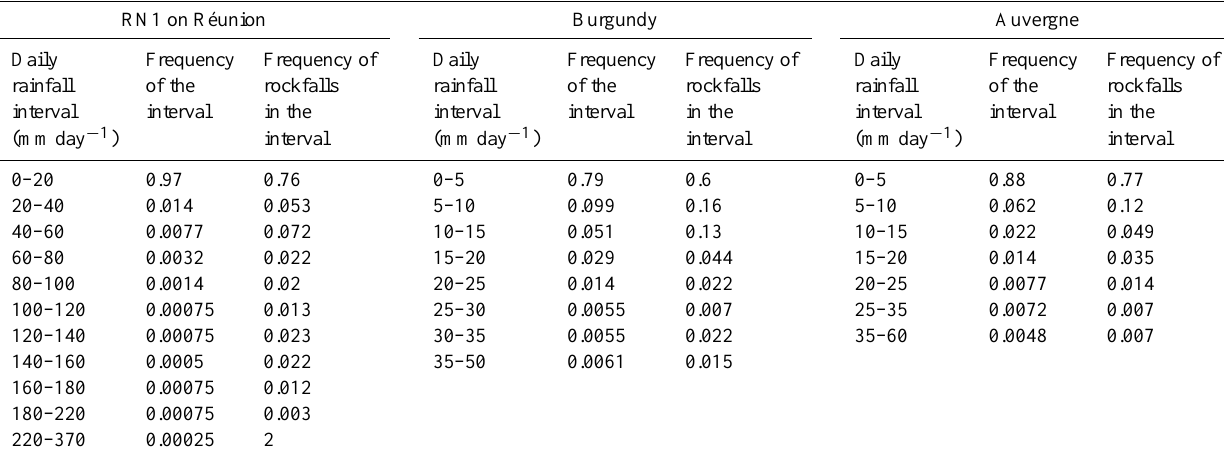
Table 2. Number of rockfalls for various intervals of daily rainfall. RN1 on Réunion Burgundy Auvergne Daily Frequency Frequency of Daily Frequency Frequency of Daily Frequency Frequency of rainfall of the rockfalls rainfall of the rockfalls rainfall of the rockfalls interval in the interval interval in the interval interval in